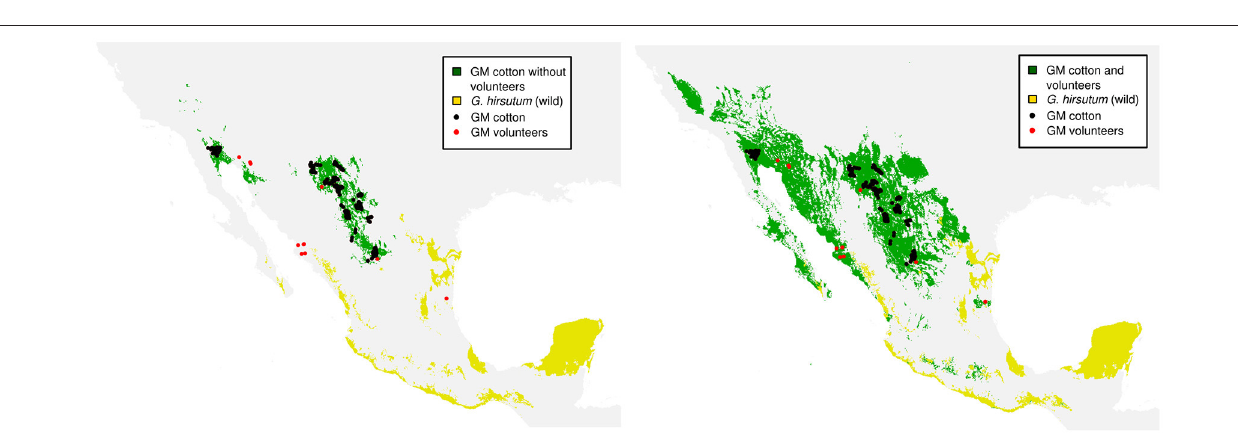
FIGURE 4 | GM cotton distribution models adding the presence of volunteers. In green: potential distribution of GM cotton. In yellow: potential distribution of wild cotton. Black dots indicate the records of GM cotton plots while red dots indicate the records of volunteer plants used for the elaboration of the